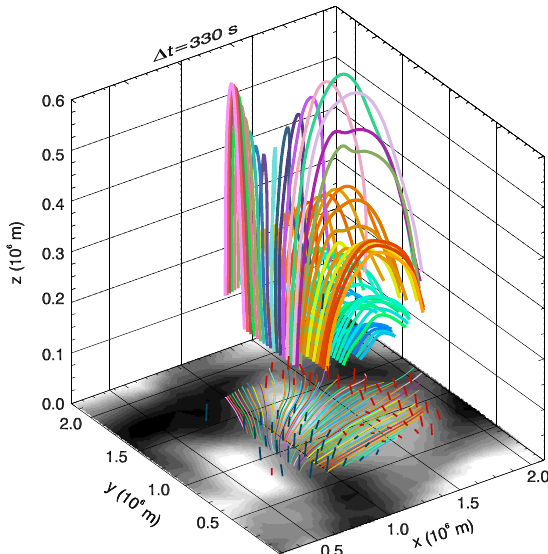
Fig. 18 Three-dimensional reconstruction of a small-scale Ω -loop observed with the Hinode SP, as derived from a potential field extrapolation. The loop encompasses the photosphere and low chromosphere. Different colors represent different field lines. The image on the horizontal plane shows the continuum intensity and the projection of several field lines. The short dashes indicate the inclination of the vector magnetic field at the loop footpoints, with blue and red marking positive and negative polarities.